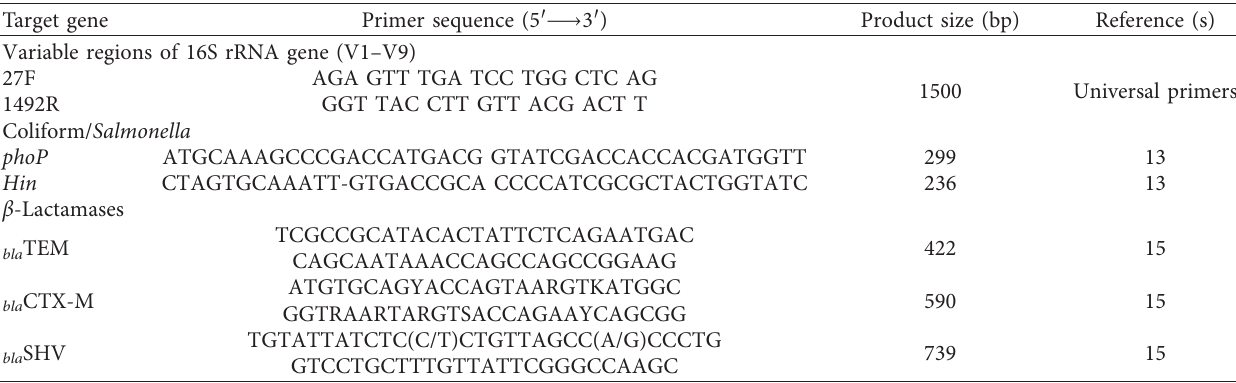
Table 1: PCR primer sequences and their targets used in this work.